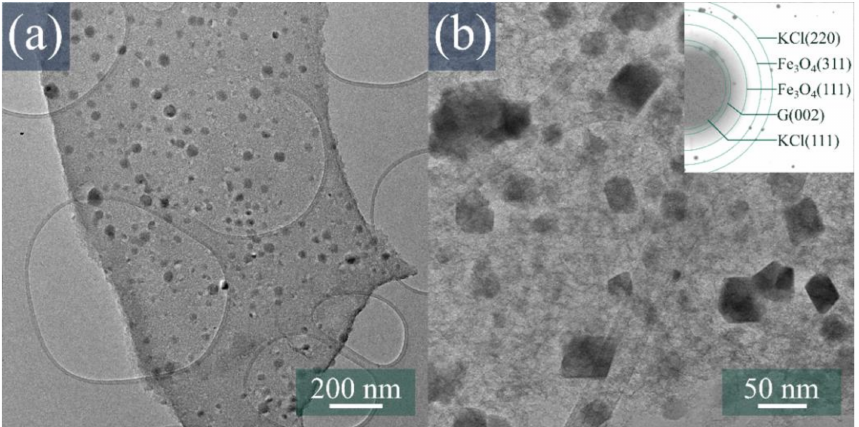
Figure 4. ( a ) Low-magnification TEM image and ( b ) TEM image and corresponding SAED patterns of as-synthesized BA-0.05